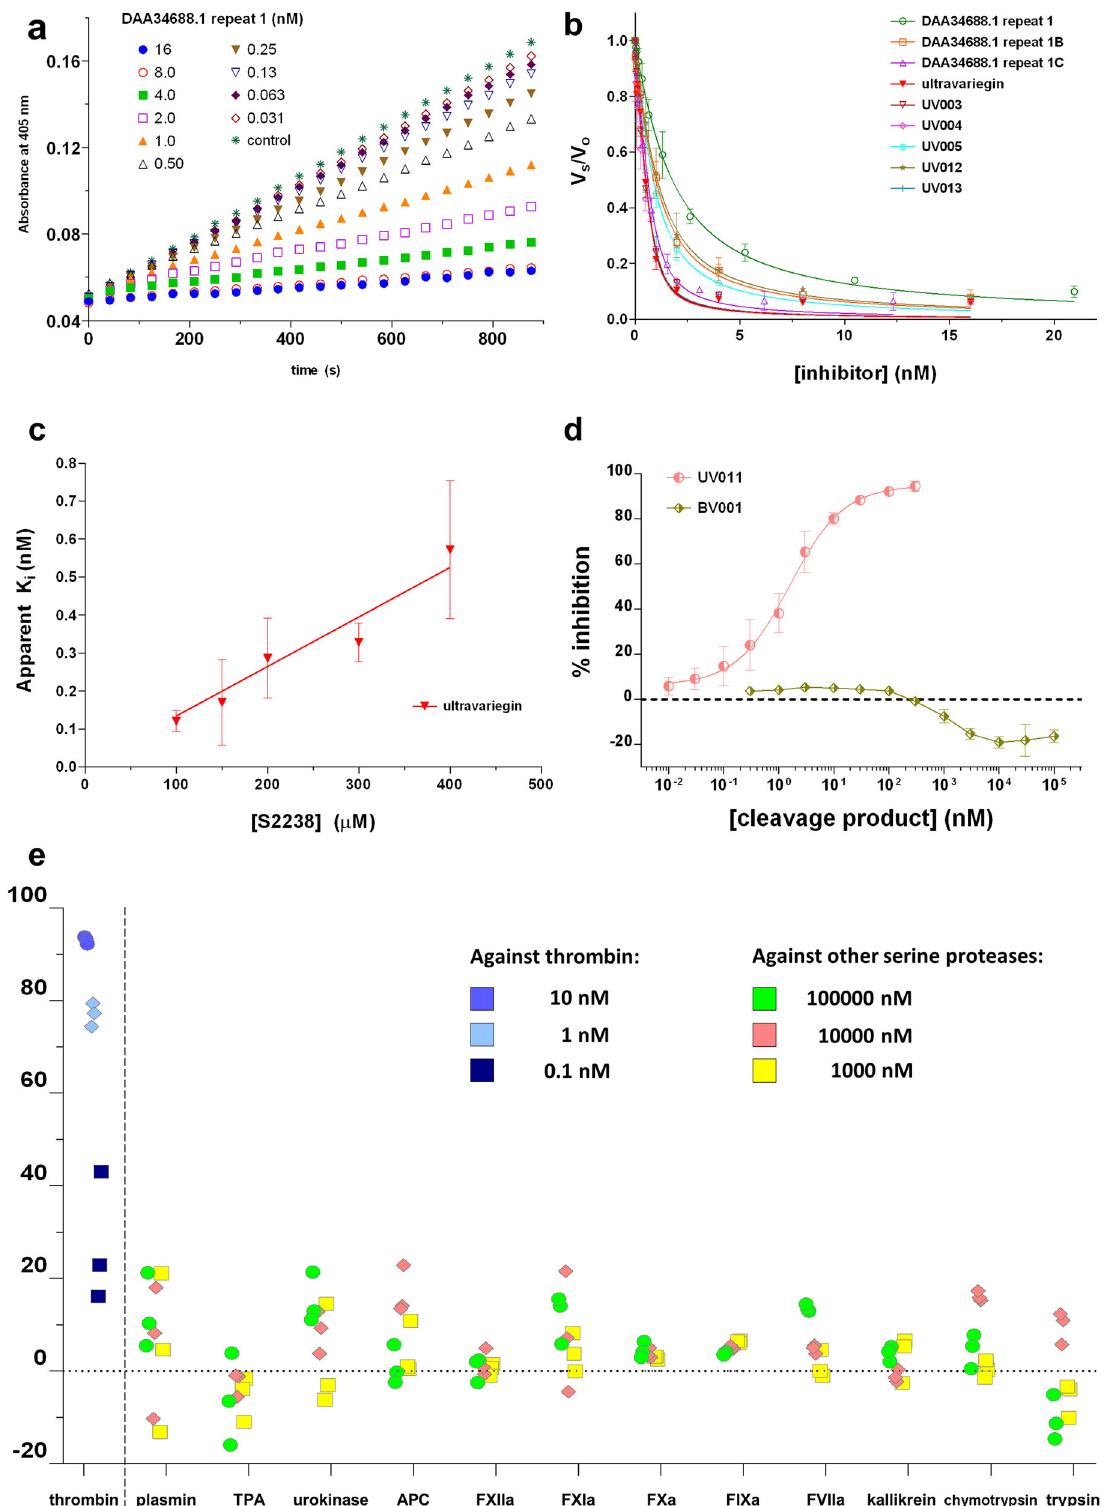
UFH while a decline only occurred when variegin, ultravariegin and bivalirudin were above 1 µM (Fig. 3b). In the thrombin-generation test (TGT), lag-time (LT) and time-to-peak (TTpeak) for thrombin generation generally increased with increasing concentrations of all four antic- oagulants in platelet-poor plasma (PPP) or platelet-rich